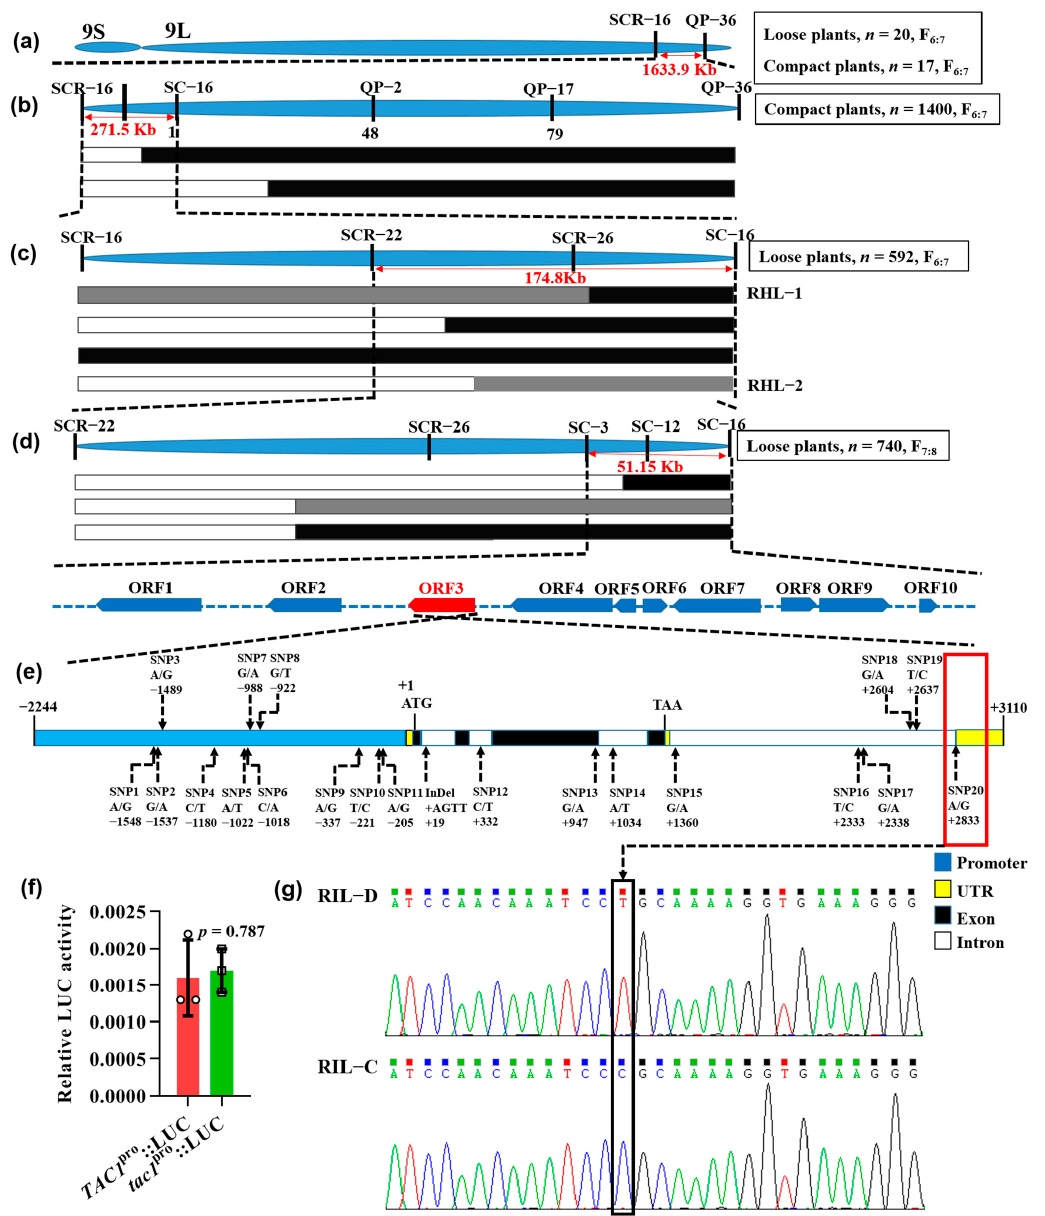
Figure 2. Map-based cloning, sequencing, and promoter activity assay of TAC1 . ( a ) The preliminary linkage interval was mapped to a 1633.9 Kb interval between InDel markers SCR-16 and QP-36 at the tail of chromosome 9 using 20 loose plants and 17 compact plants from the F 6:7 RIL population at DAS110 under natural short-day (NSD) conditions. ( b ) The candidate locus was narrowed down to a 271.5 Kb region flanked by SCR-16 and SC-16 using 1400 compact plants from the F 6:7 RIL population. ( c ) The mapping interval was further narrowed down to a 174.8 Kb region between SCR-22 and SC-16 using 592 loose plants from the F 6:7 RIL population, while two heterozygous plants were selected for generating RHL-1 and RHL-2. ( d ) The candidate region containing 10 ORFs was finally mapped to a 51.15 Kb interval between SC-3 and SC-16 using 740 loose plants from RHL-2 at DAS60 under natural long-day (NLD) conditions. ( e ) Sequencing analysis of the 5354 bp TAC1 genomic sequence. ( f ) The TAC1 ( tac1 ) promoter activity assays with the Dual-Luciferase ® Reporter Assay System. Data are displayed mean ± SD ( n = 3). Two-tail Student’s t -test was used for statistical analysis. ( g ) DNA sequencing chromatograms of the splicing sites of 3 (cid:48) -untranslated region of TAC1 between RIL-D and